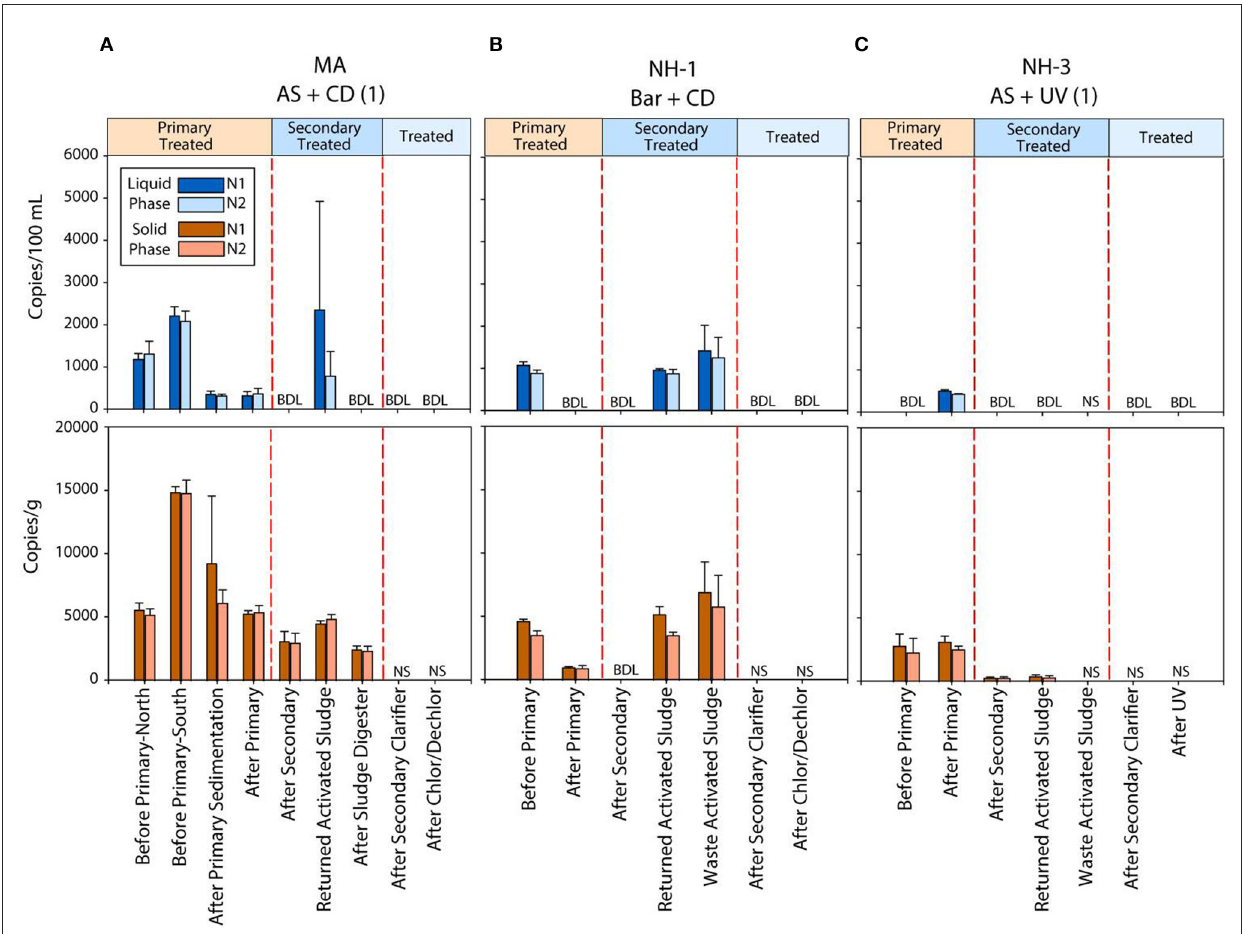
FIGURE1 Concentration of two SARS-CoV-2 RNA biomarkers (N1 and N2) measured using RT ddPCR in the liquid and solid phases of untreated and treated wastewater samples from three coastal New England WWTPs (MA, NH-1 and NH-3) (A–C) . Liquid phase concentrations are shown as blue bars, while solid phase concentrations are shown in brown. N.S. indicates no sample was analyzed due to limited solids recovery. BDL represents concentrations below the limit of detection of the instrument.